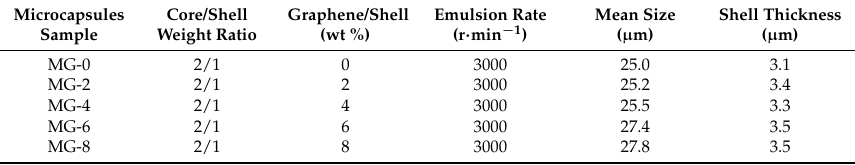
Table 1. Characters of microcapsules with various graphene contents in the